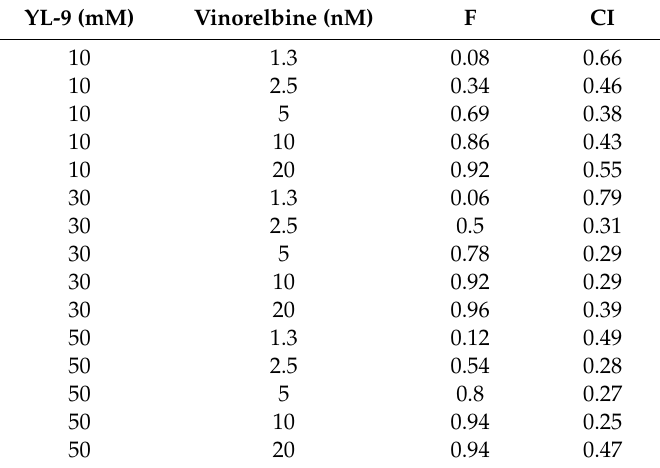
Table 1. The combination index (CI) of combination treatment between vinorelbine and YL-9 in NCI-H460